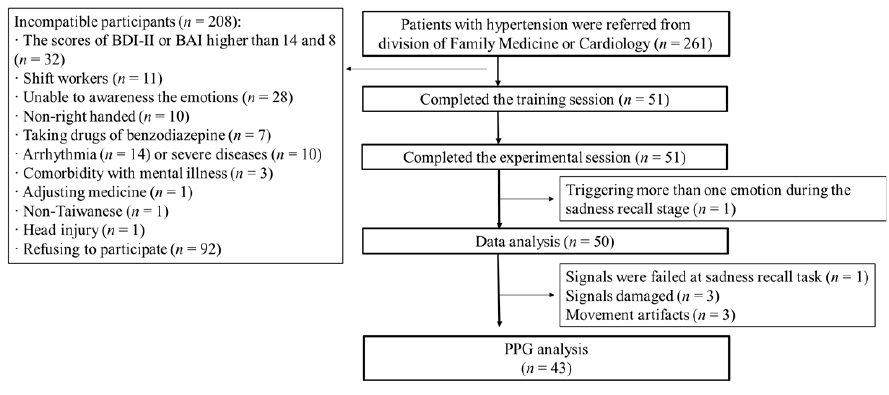
Figure 1. Participants ’ study flow.